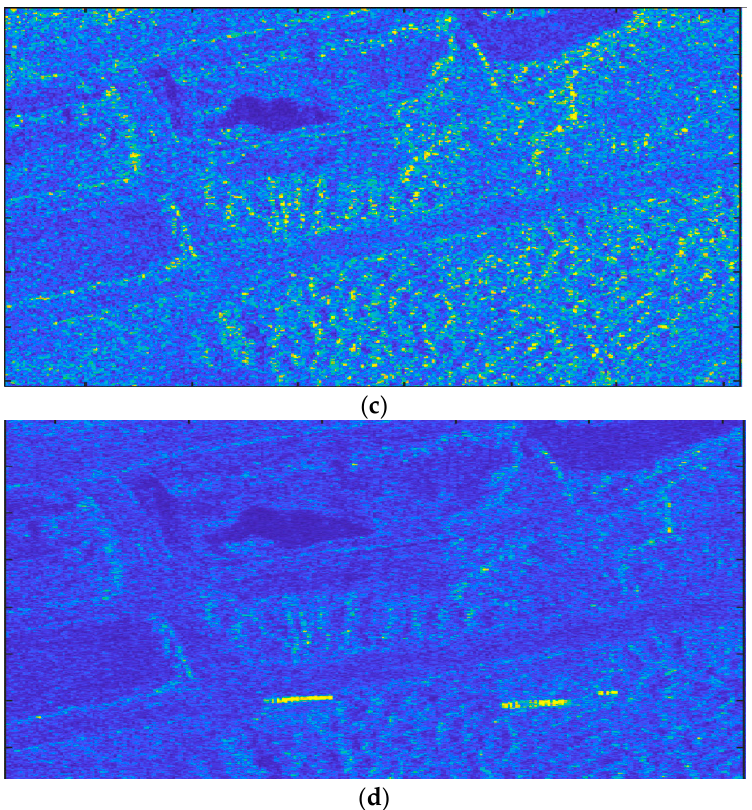
Figure 6. The result of the radar imaging: ( a , c )—parts of the image obtained by the classical method; ( b , d )—more informative image obtained in accordance with the new method of signal processing. Table 1. Quantitative assessments of the quality of coherent image